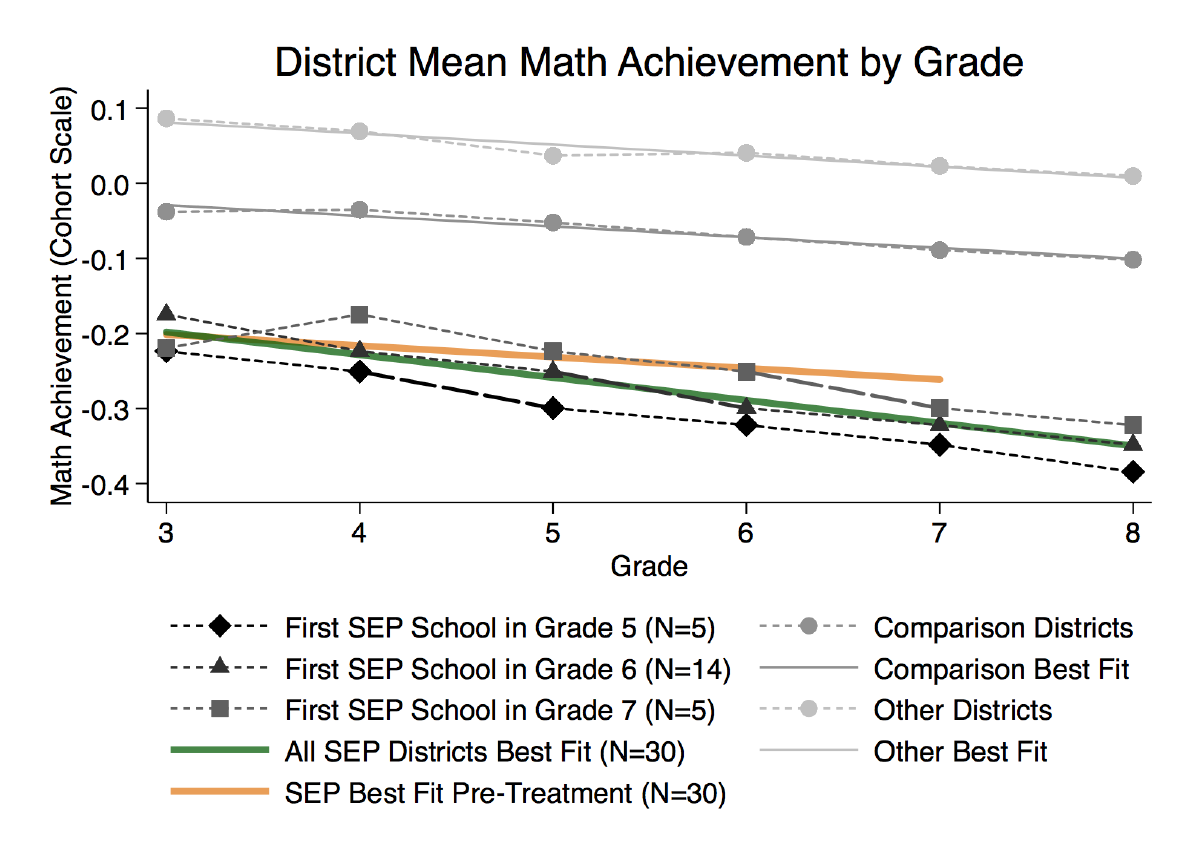
Figure 3: Grade-level achievement in SEP districts versus other districts. Note: For pretreatment SEP district sample, the sample size at each grade level is as follows: third = 30, fourth = 27, fifth = 22, sixth = 8, seventh =